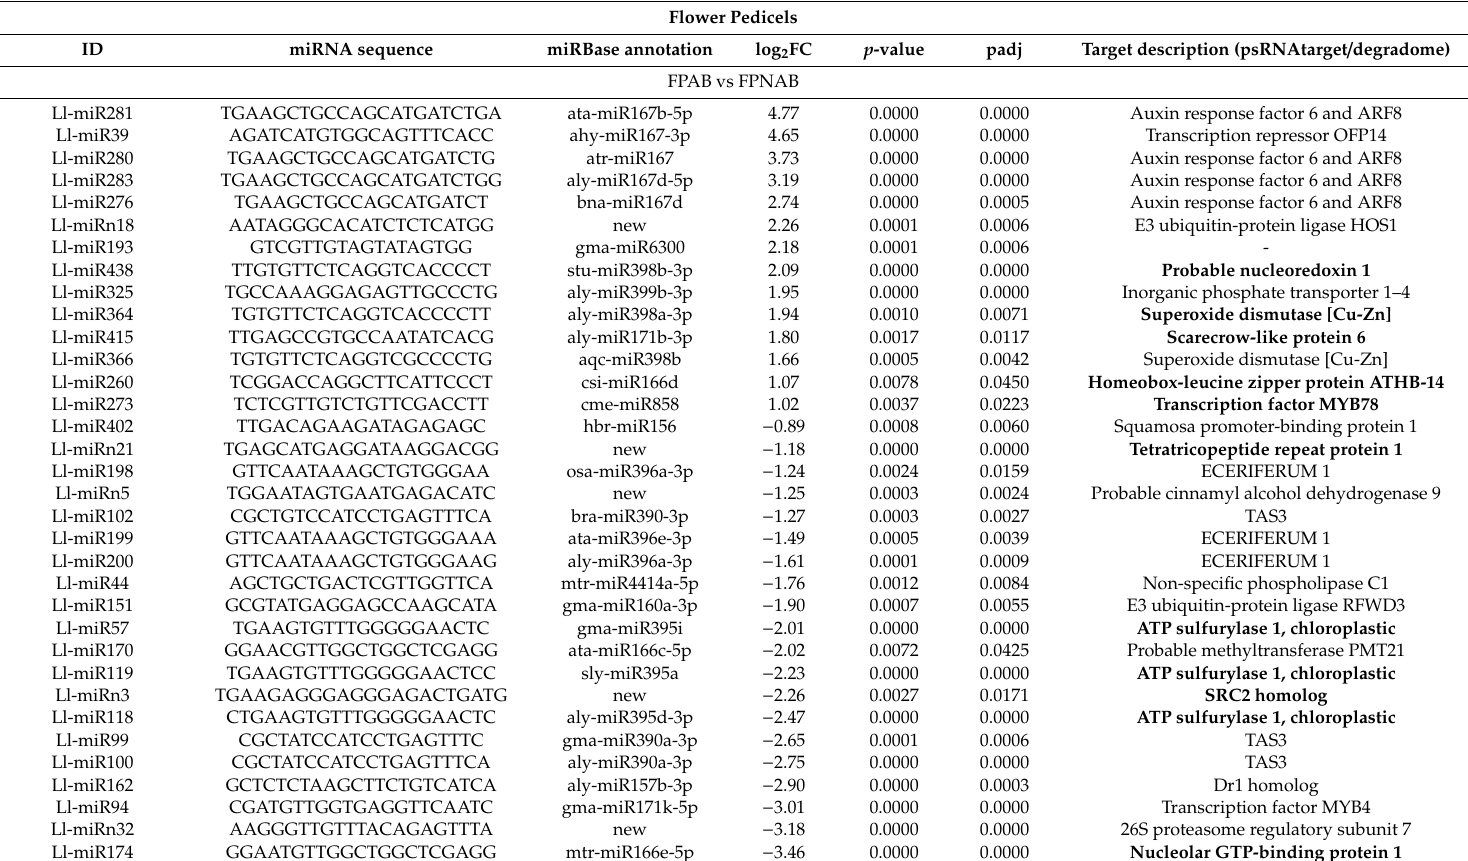
Table 6. Di ff erentially expressed miRNAs identified in comparisons between pedicels collected from abscised or non-abscised flowers (FPAB vs FPNAB) with padj <